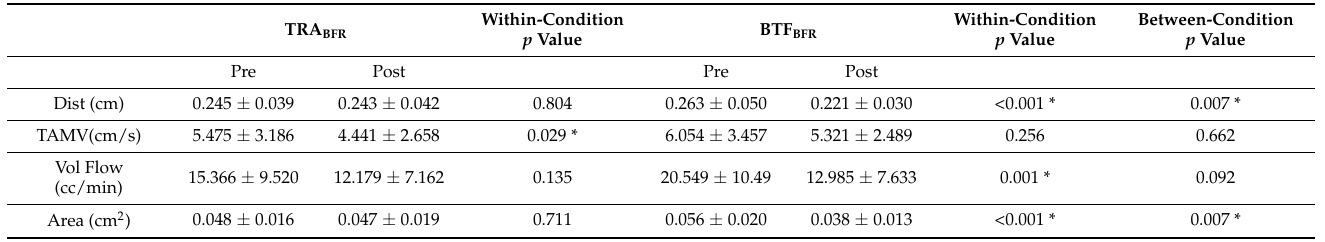
Table 2. Changes in arterial flow following blood flow restriction and band tissue flossing (M ±